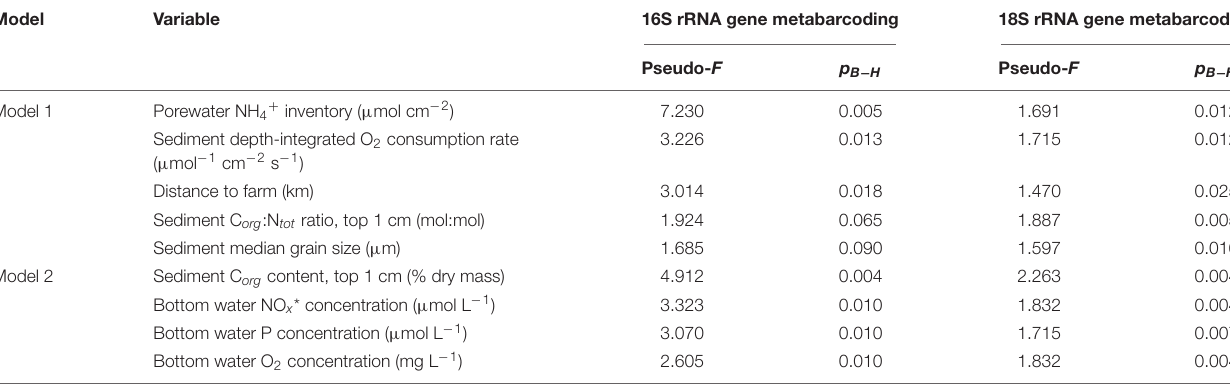
TABLE 6 | Permutation test results for db-RDA explanatory variables (999 permutations).